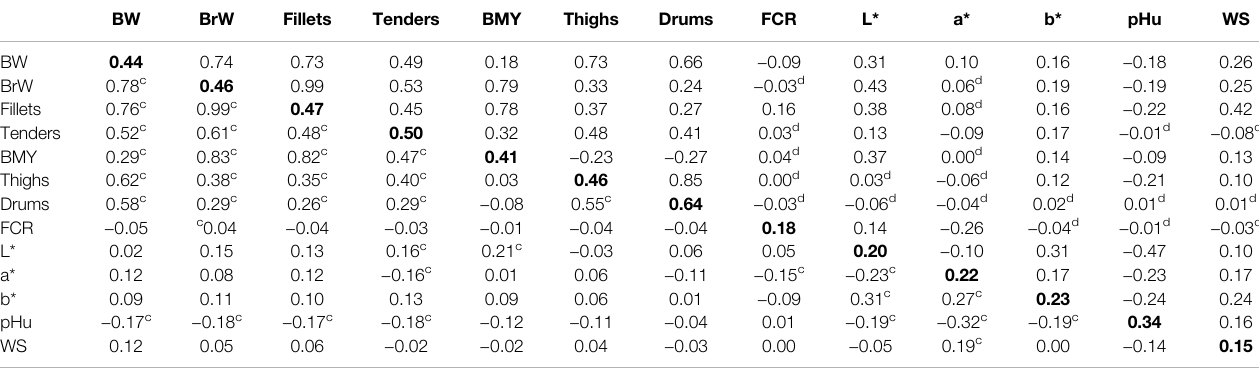
TABLE 2 | Heritability a (diagonal), additive genetic correlation coef fi cients b (above diagonal), and partial phenotypic correlation coef fi cients (below diagonal). BW